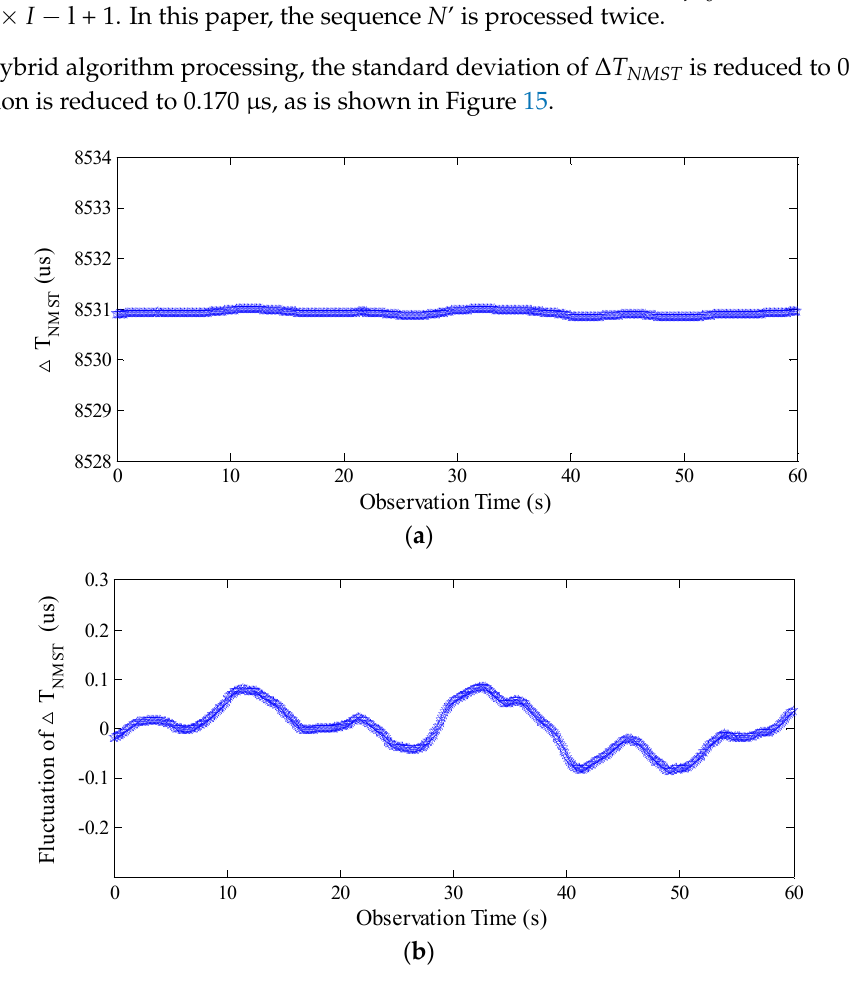
Figure 15. The Δ T NMST and fluctuation after processing by the hybrid algorithm. ( a ) Δ T NMST after Figure 15. The ∆ T NMST and fluctuation after processing by the hybrid algorithm. ( a ) ∆ T NMST after hybrid algorithm processing; ( b ) The fluctuation of Δ T NMST after hybrid algorithm processing. hybrid algorithm processing; ( b ) The fluctuation of ∆ T NMST after hybrid algorithm